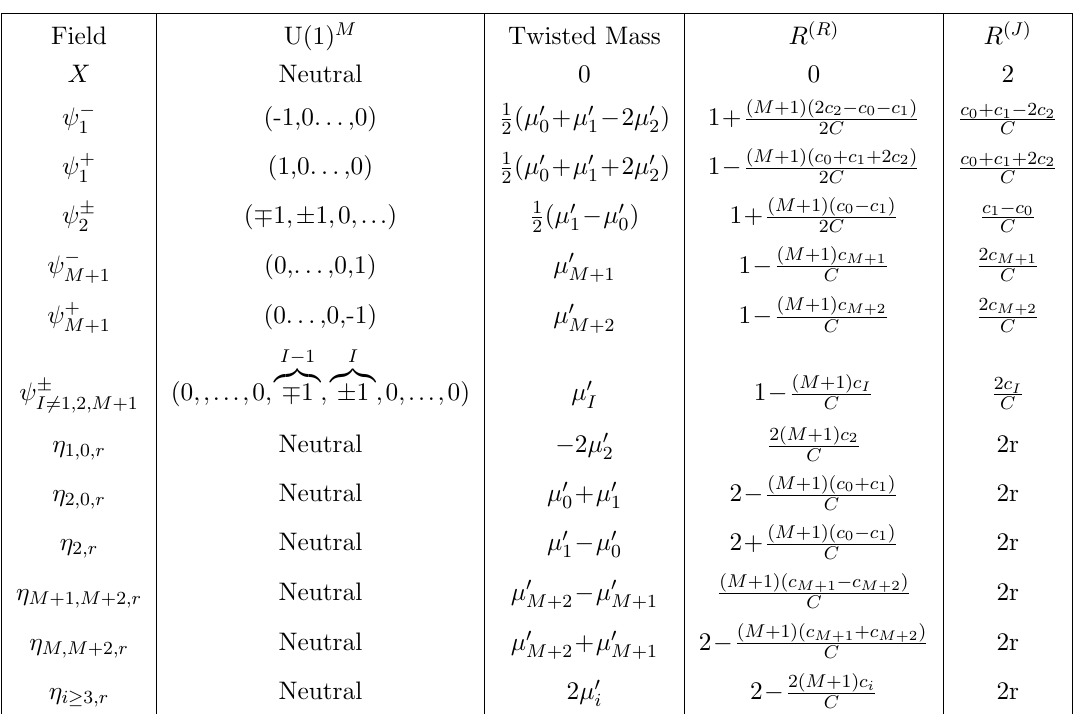
Table 6 . The spectrum on the worldsheet for S -dual strings described in